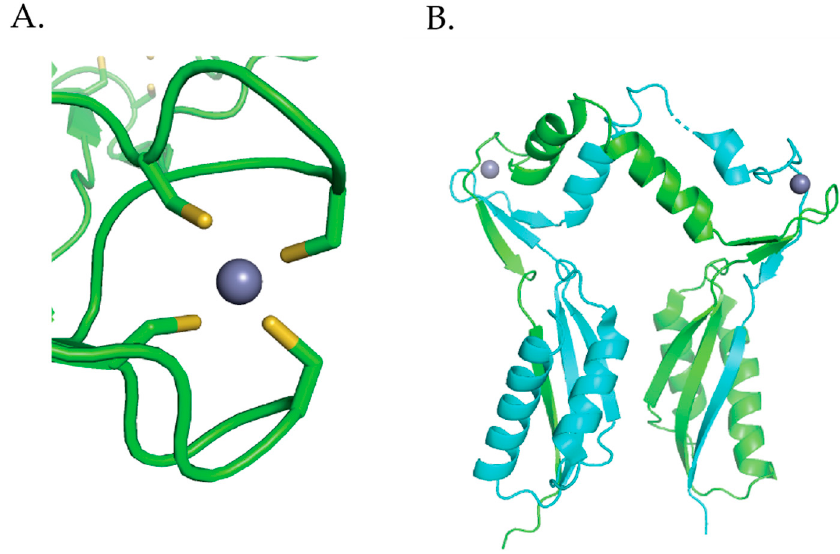
Figure 9. Crystal structure of HypA from T. kodakarensis [99]. The protein monomers are shown in cyan and green and the zinc ion is shown as a slate sphere. ( A ) The zinc site from the monomeric protein (PDB ID 3A43) [99]. ( B ) Crystal structure of the domain swapped dimer (PDB ID 3A44) [99]. (Figure adapted with permission from Higgins, K.A.; Carr, C.E.; Maroney, M.J. Specific Metal